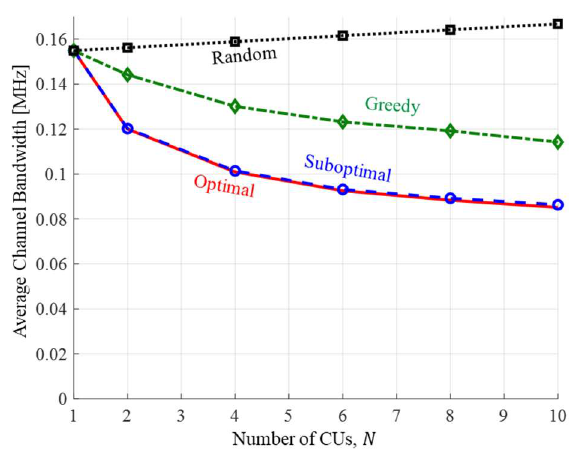
Figure 5. Comparison of average channel bandwidths of different channel assignment schemes.